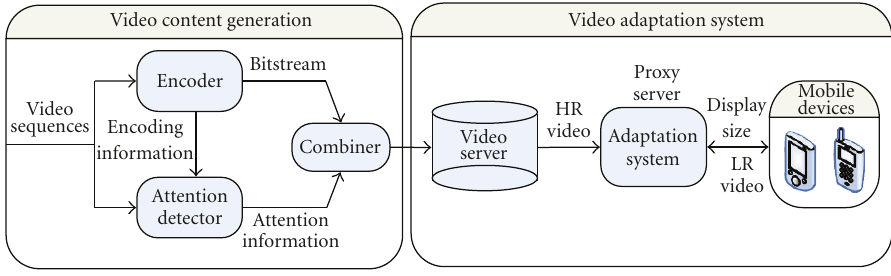
Figure 1: The structure of attention-information-based spatial adaptation